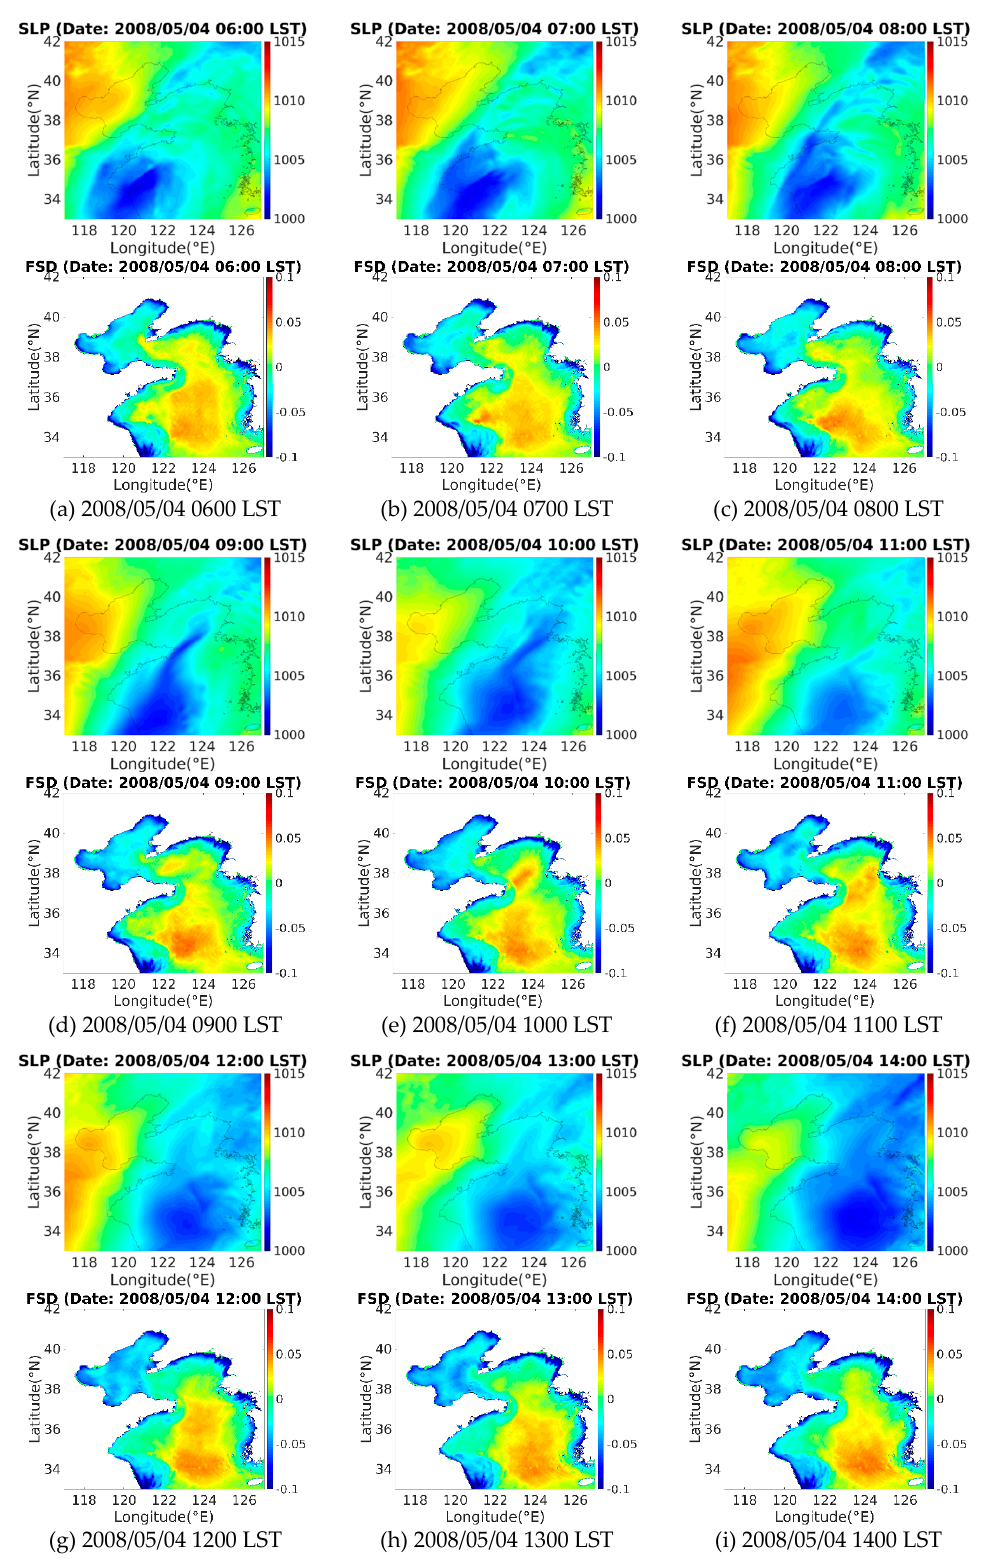
Figure 9. The free surface displacement (FSD, bottom) and sea level pressure (SLP, above) change in the Yellow Sea during the meteotsunami that occurred in May 2008. ( a ) 0600 LST 4 May 2008; ( b ) 0700 LST 4 May 2008; ( c ) 0800 LST 4 May 2008; ( d ) 0900 LST 4 May 2008; ( e ) 1000 LST 4 May 2008; ( f ) 1100 LST 4 May 2008; ( g ) 1200 LST 4 May 2008; ( h ) 1300 LST 4 May 2008; ( i ) 1400 LST 4 May